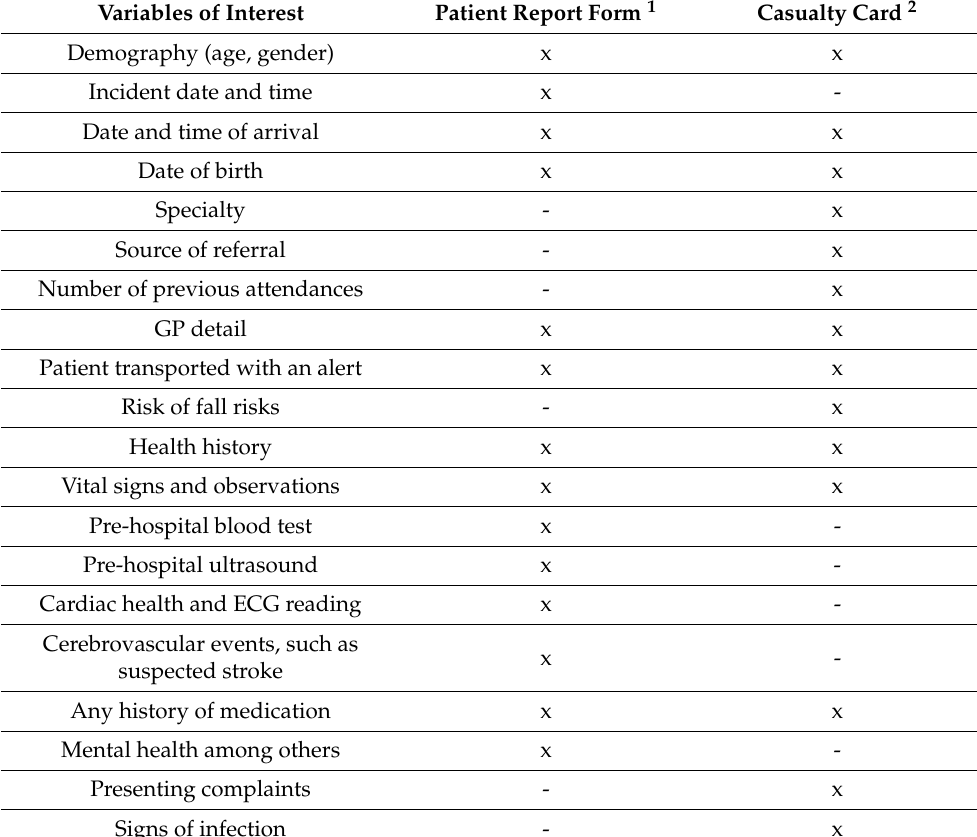
Table 4. Information available to staff prior to patient entry into